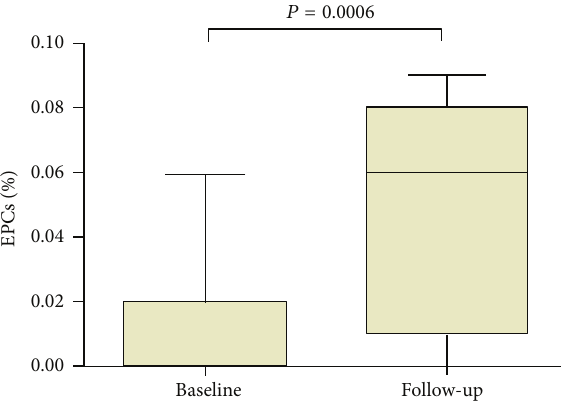
Figure 2: Mean percentage of EPCs before and after 3 months of anti-TNF treatment. EPCs:endothelial progenitor cells.